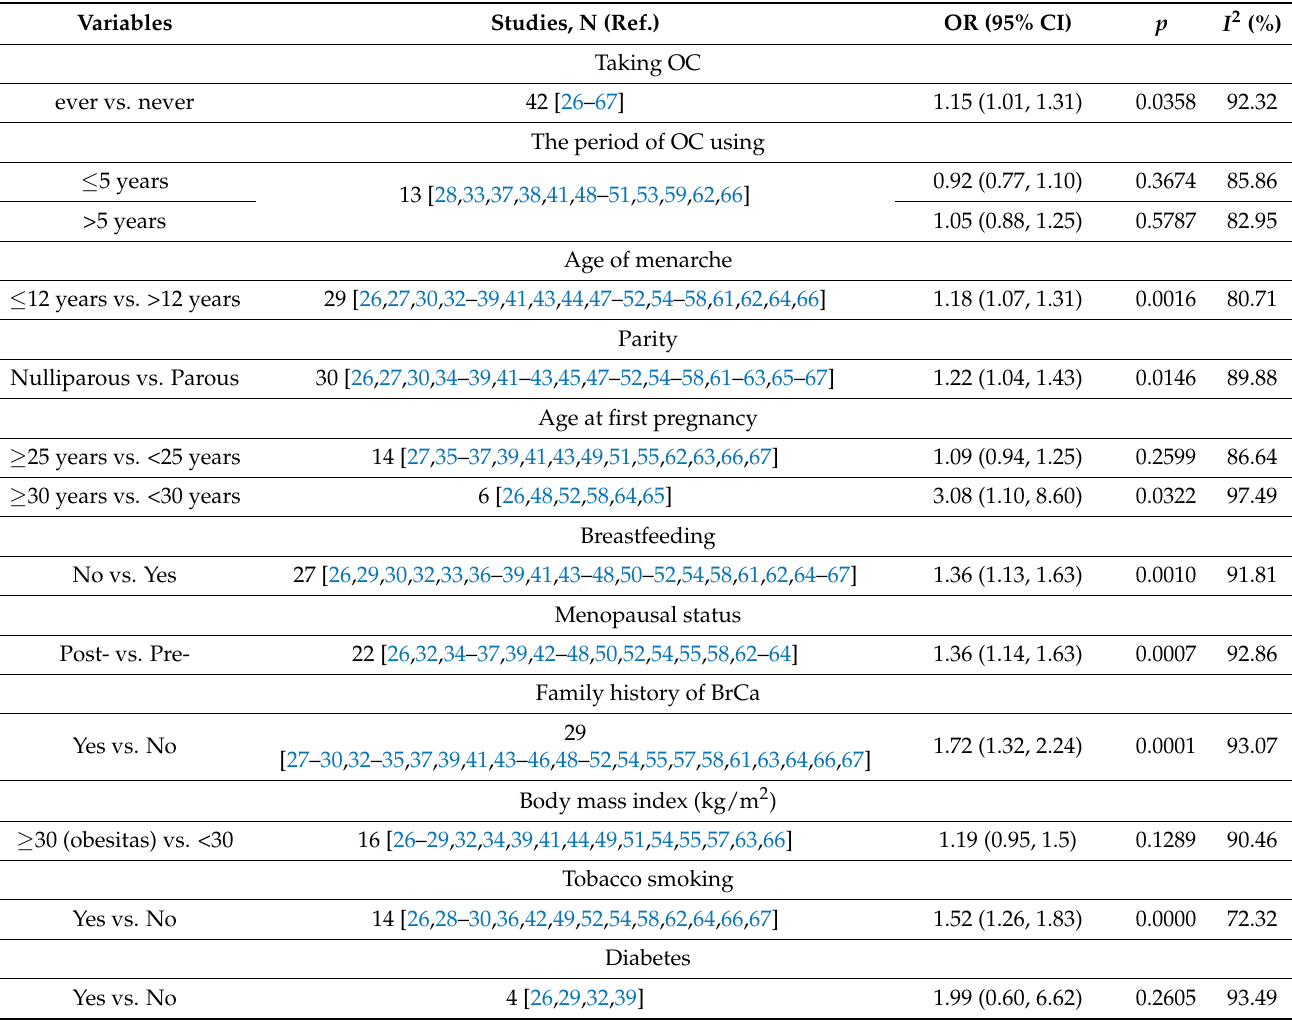
Table 2. Analysis of the potential modifying effects of other risk factors on the relationship of OC use and BrCa risk. Variables